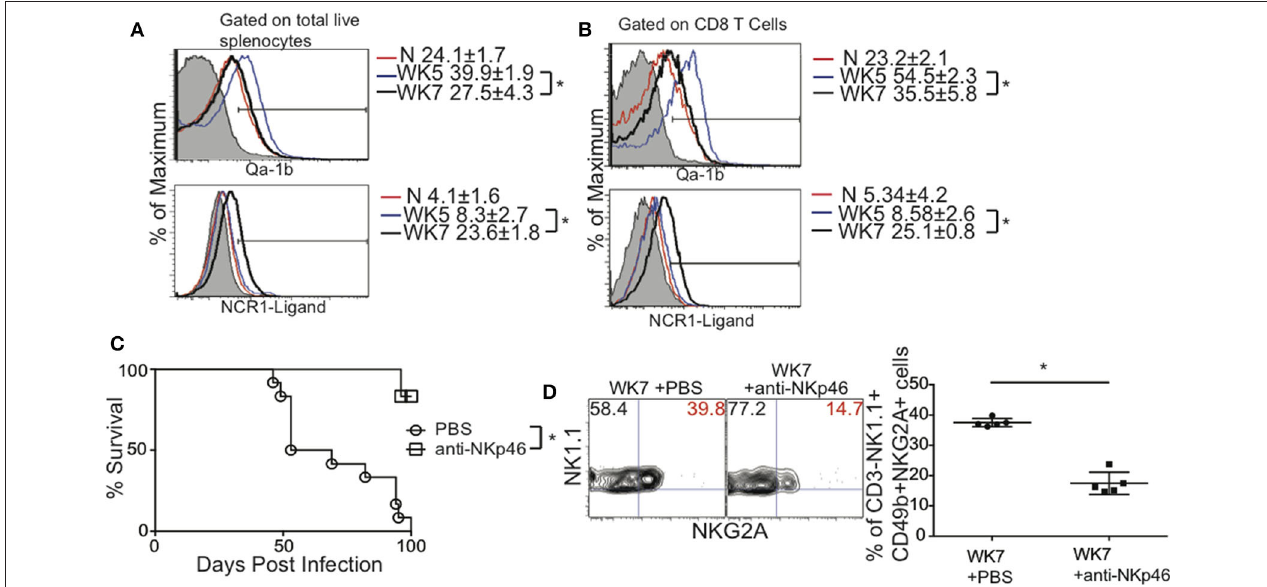
FIGURE 7 | Blockade of NKp46 rescues mice from death caused by CD8 + T cell exhaustion induced parasite reactivation. C57BL/6 mice were orally infected as above and total splenocytes were assayed for NKG2A ligand Qa-1b and NKp46 ligand using soluble NCR1 fused to human Ig Fc. (A) Histograms present the MFI ± SD of QA-1b (top) and NCR1-ligand (bottom) from total splenocytes. (B) Histograms present the MFI ± SD of QA-1b (top) and NCR1-ligand (bottom) from CD8 + T cells. (C) Mice were infected with 10 cysts of ME49 i.g. and treated with 50 µ g of anti-NKp46 or 1 X PBS i.p. starting at week 5 p.i. Mice were treated every other day for the duration of this experiment. The survival graph presents pooled data from 3 independent experiments with n = 4–5 mice per group. The log-rank (Mantel-Cox) test was used to evaluate survival rates. (D) Mice were infected with 10 cysts of ME49 i.g. and treated with 50 µ g of anti-NKp46 or 1 X PBS i.p. starting at week 5 p.i. Mice were treated every other day for the duration of this experiment and harvested 2 weeks after start of treatment. The frequency of CD3–NK1.1 + CD49b + NKG2A + NK cells was measured in the spleen. Contour plots and graph present frequency of NK1.1 + NKG2A + spleen cells from 1 experiment repeated independently twice with n = 5 mice per group. *denotes significance with p ≤